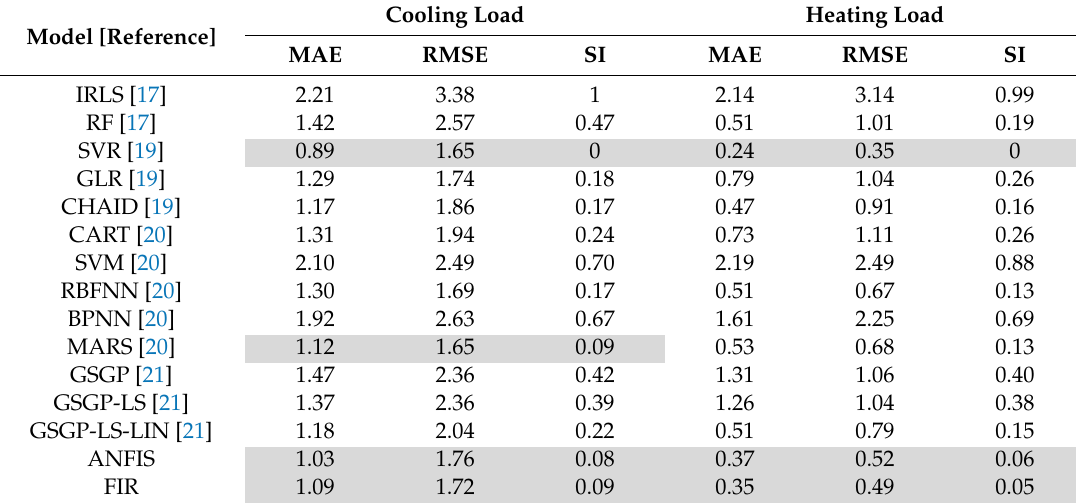
Table 2. RMSE (root mean square prediction errors), MAE (mean absolute prediction errors) and SI (synthesis index) obtained by all the machine learning methodologies, including the fuzzy approaches, ANFIS and FIR, at the bottom of the table. Near the name of each model the reference of the paper is included. The best prediction performances are